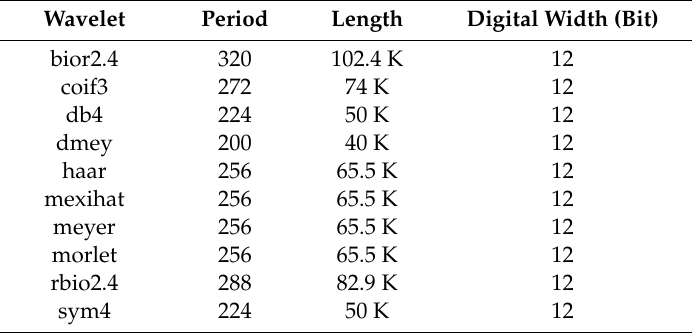
Table 1. Experimental signal